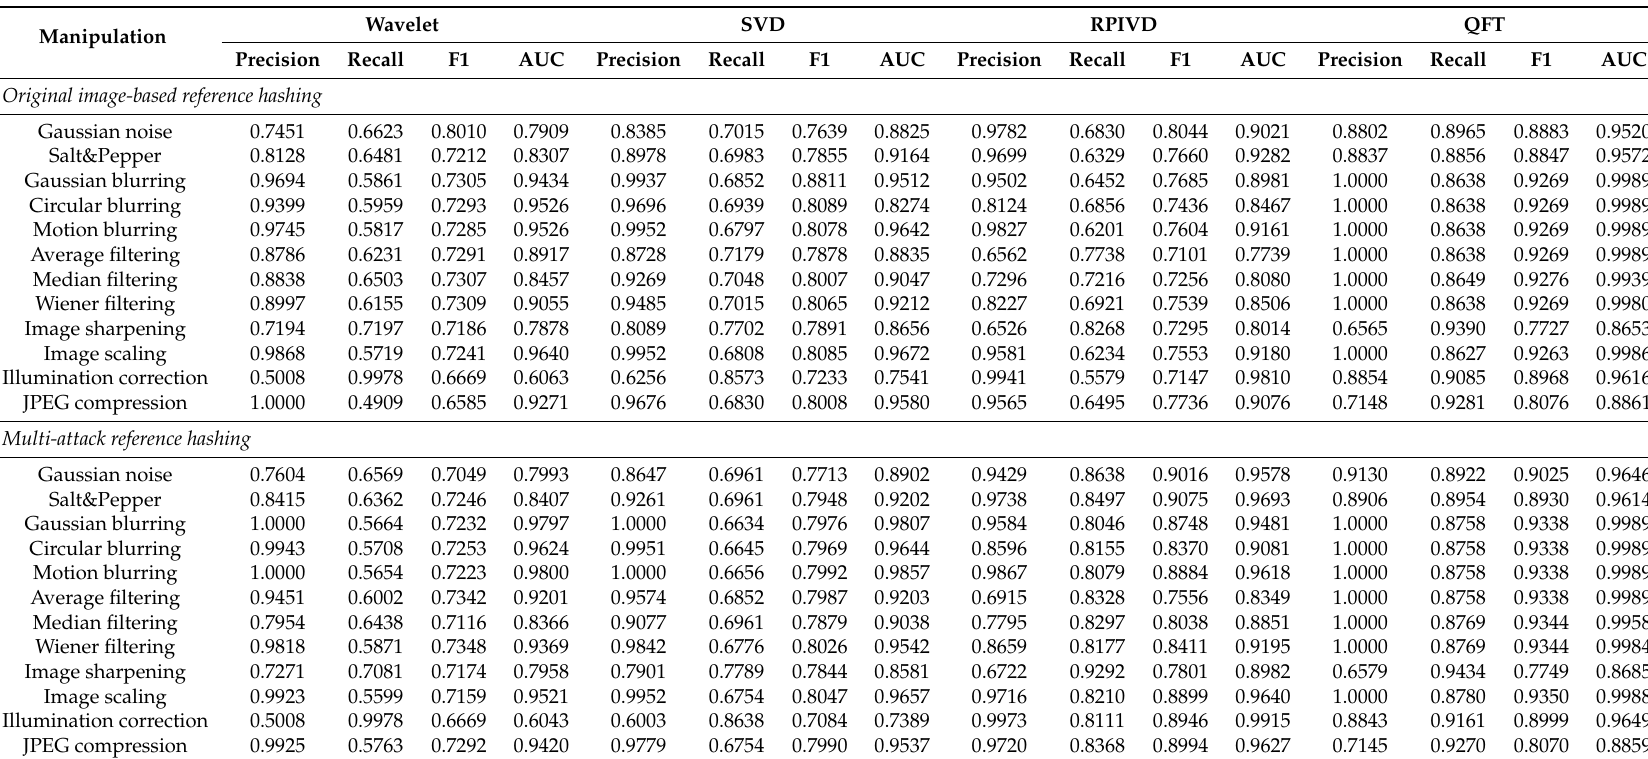
Table 3. Comparisons between original image-based reference hashing and the proposed multi-attack reference hashing (CASIA dataset). Wavelet Manipulation Precision Recall Original image-based reference hashing Gaussian